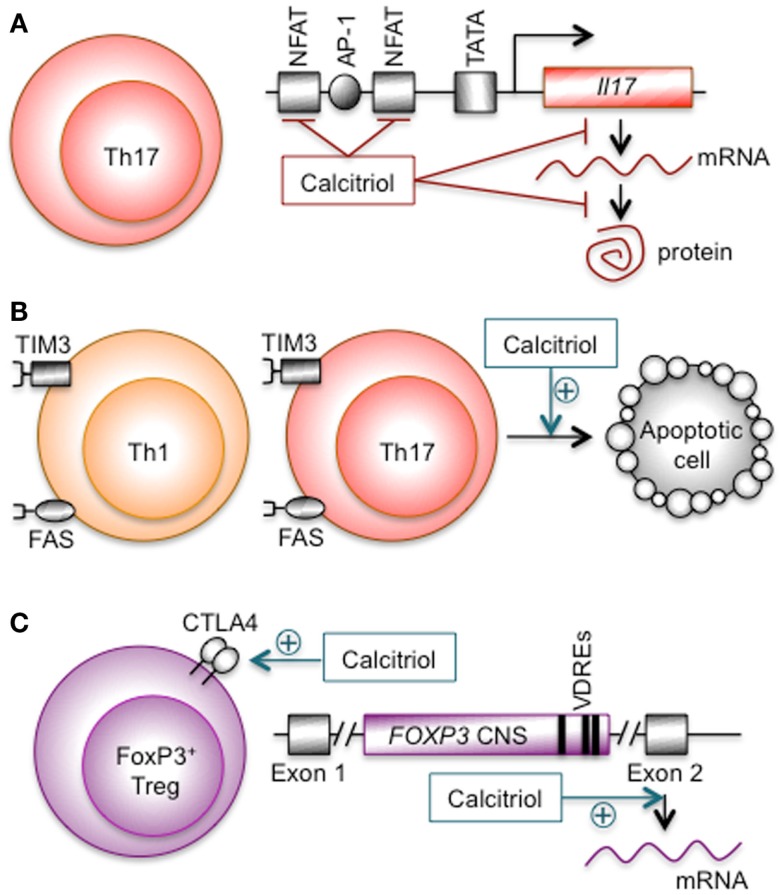
Proposed calcitriol mechanisms in effector Th1, Th17, and FoxP3+ Treg cells. (A) Calcitriol and IL-17 synthesis in Th17 cells. Calcitriol inhibited IL-17 synthesis in a VDR-dependent manner by a post-transcriptional mechanism (183, 187). It also blocked NFAT, recruited histone deacetylase, and sequestered Runx1 to suppress murine Il17 gene transcription (185). (B) Calcitriol and effector CD4+ T-cell apoptosis. Calcitriol increased CD4+ T-cell sensitivity to extrinsic cell death signals that may have been transduced through the FAS ligand–FAS–caspase-8 and/or the galectin-9–TIM3–calpain pathways (208–210, 216). (C) Calcitriol and FOXP3 gene transcription. Calcitriol increased the transcription of the murine FoxP3 (185) and human FOXP3 genes (217). Three VDREs that functioned as calcitriol-dependent enhancers were identified in a conserved non-coding sequence (abbreviated CNS in this diagram) between exons 1 and 2. Calcitriol also increased CTLA4 protein expression (218–220).